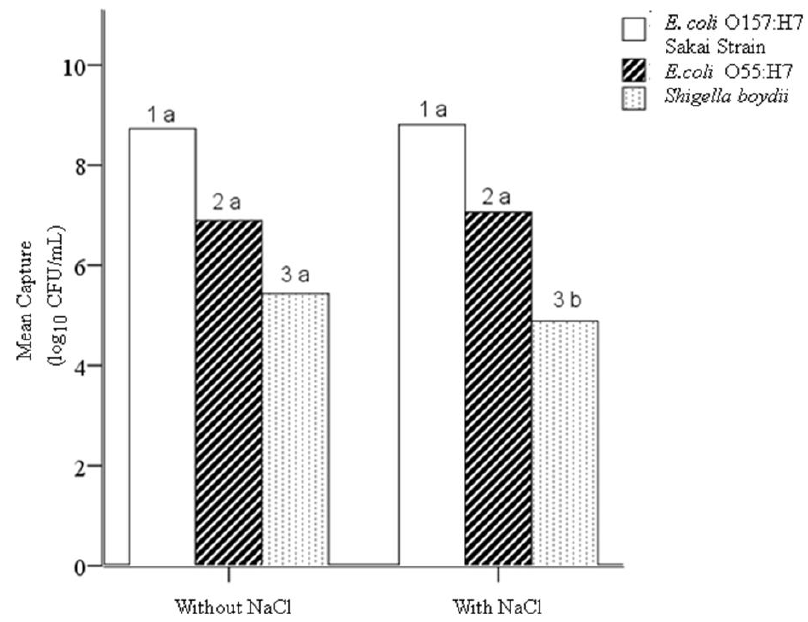
Figure 3. Mean concentration (log 10 of CFU/mL) of each bacterial culture captured in IMS, using Mab-EAMNPs made with and without the addition of sodium chloride. Statistical comparisons were made within numbered groups (1–3), and letters (a or b) indicate significant differences (α = 0.05, n = 178; p = 0.029). Zero counts were estimated to facilitate analysis [23].